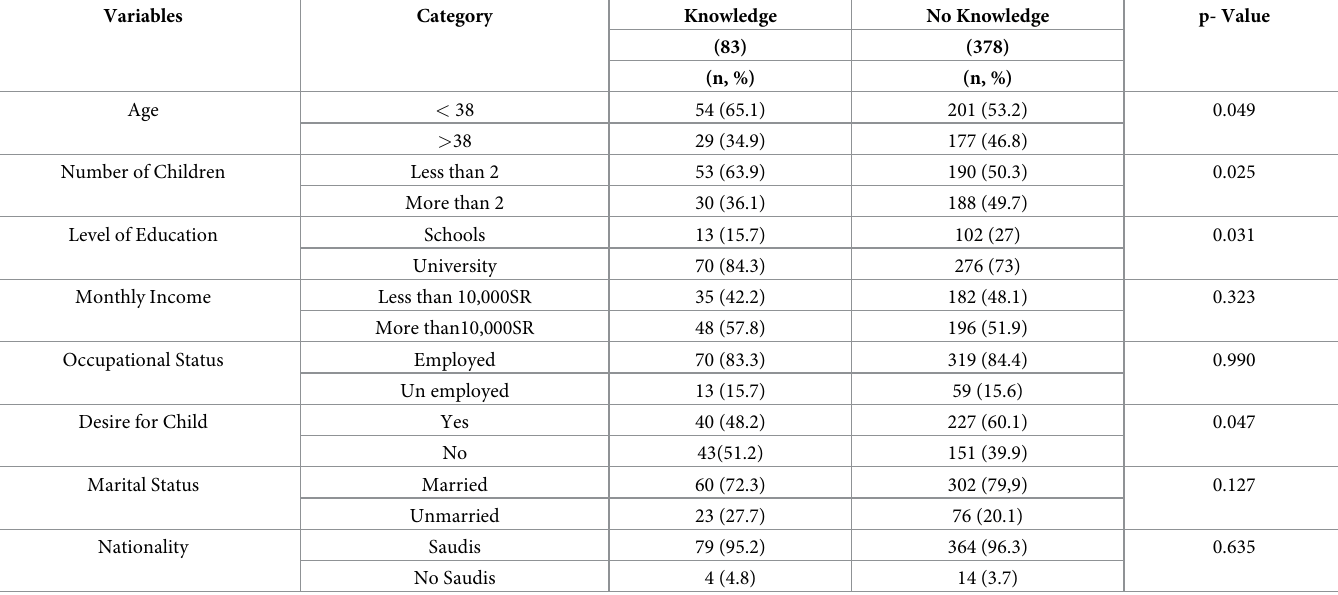
Table 2. Difference in characteristics of men with or without knowledge about emergency contraception.